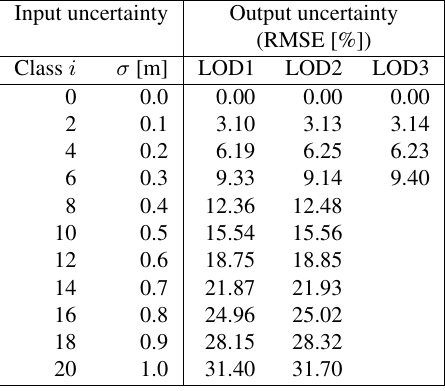
Table 2: The RMSE ( µ x,i ) , expressed in percent, for each accu- racy class and LOD.